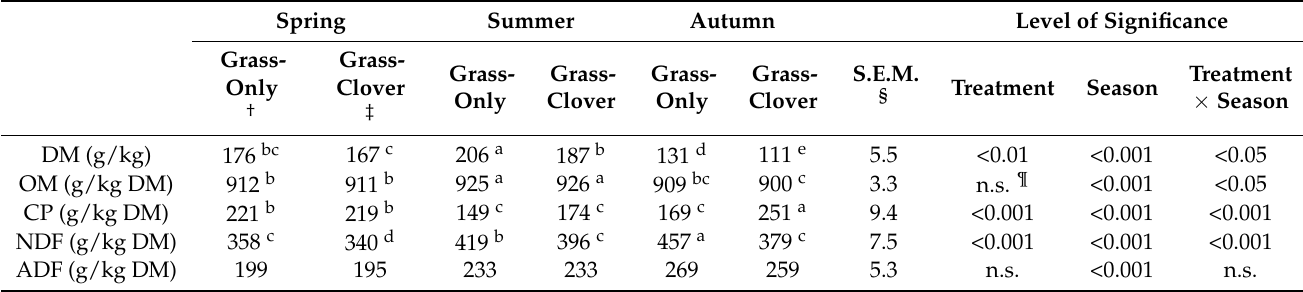
summer (Table 2). In autumn, however, the grass-clover sward had significantly greater CP (Figure 2) and less NDF (Figures 3 and 4) than the grass-only sward ( p < 0.001; Table 2). Dry matter percentage was significantly affected by treatment and season. It was higher in grass-only than grass-clover ( p < 0.001) and was highest in summer and least in autumn ( p < 0.01). Season had a significant ( p < 0.001) effect on both OM concentration, which was least in autumn and greatest in summer, and ADF concentration, which was least in spring and increased from spring to summer and summer to autumn. Table 2. Sward chemical composition of the forage offered to individually housed sheep in spring (27 March–29